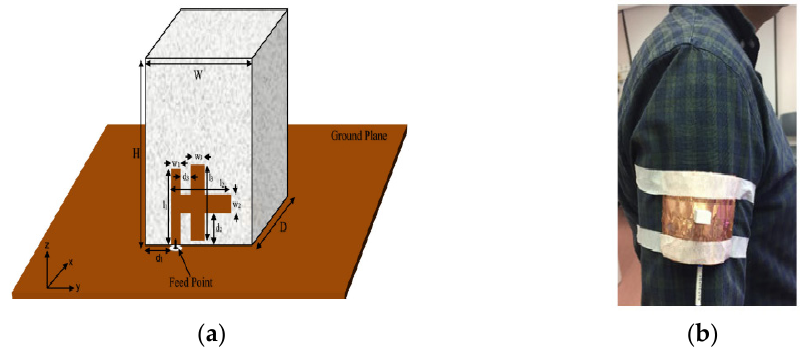
Figure 25. Wearable DRA: ( a ) proposed configuration; ( b ) antenna on a human body [102].